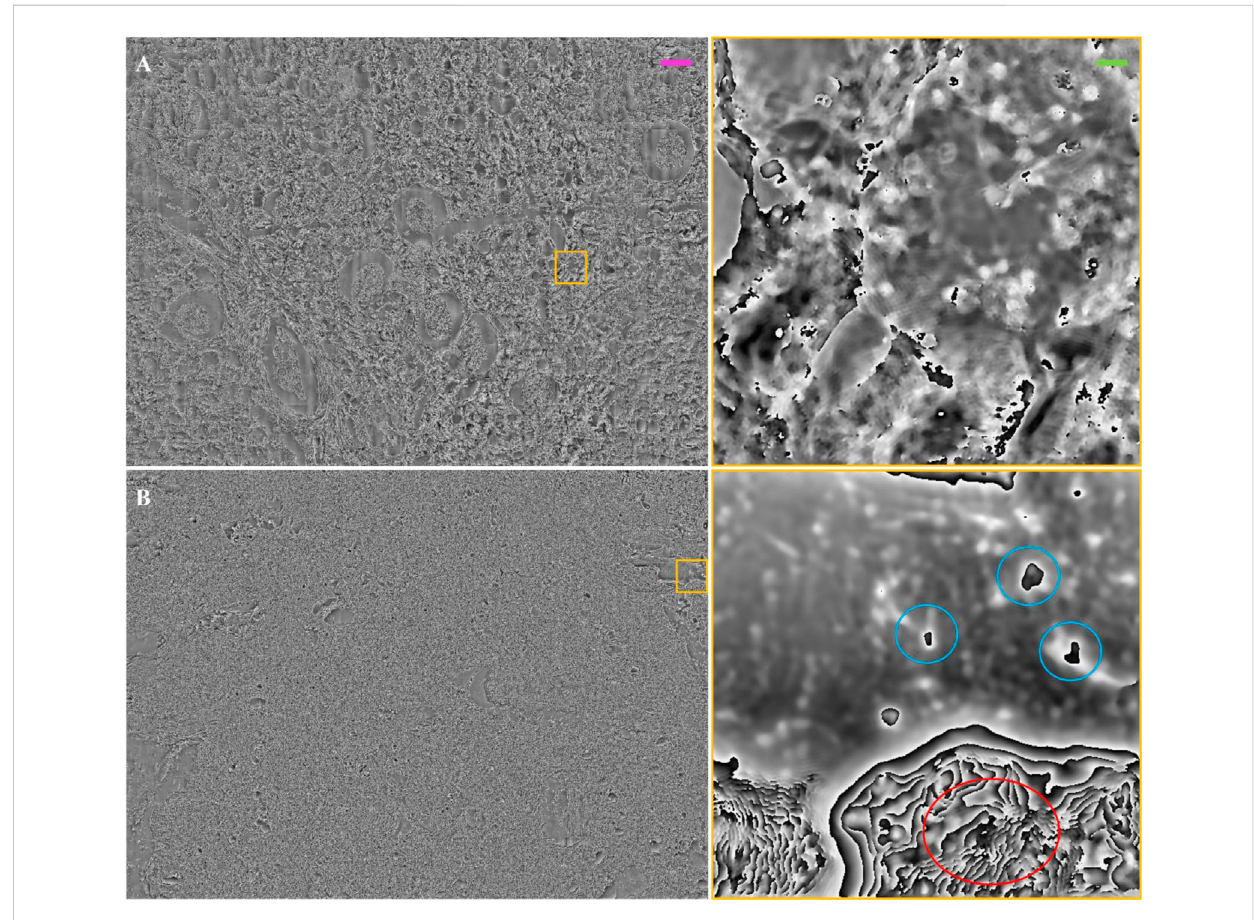
FIGURE 8 Thick/unstained FP phase images: (A) FP phase map of unstained renal tissue 20 µm thick. The inset on the right is a zoom of the yellow box; (B) FP phase map of unstained renal tissue 30 µm thick. The inset on the right is a zoom of the yellow box. The light blue circles show tissue elements that behave as pure phase objects, for which the thin object assumption stands, and after phase wrapping can return the optical thickness measure. The red circleisawrappedphasezonewherethephasemightbenotde fi nedduetolightscatteringorabsorptionfromthethicktissue.Thepurplescalebar for the full fi eld of view images is ~105 μ m, while the green one on the zoomed patches is ~7.5